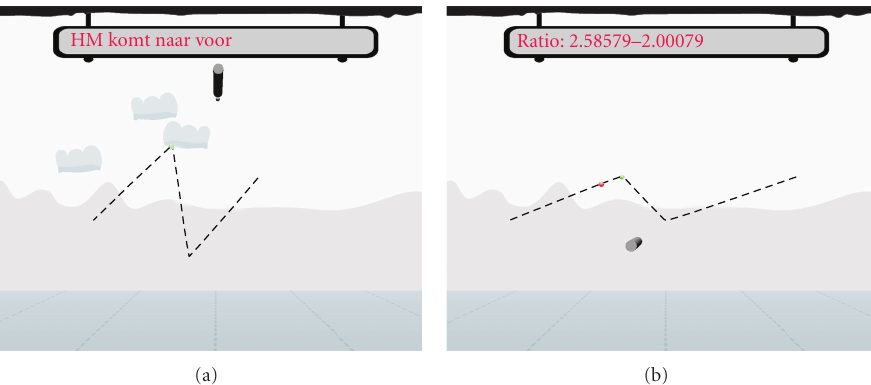
Figure 4: The two curves used in the benchmarking test. Curve 1 (a) with a high curvature, curve 2 (b) with much less curvature. Note that the visual representation only shows the straight lines, while the haptic simulation uses the spline interpolation.